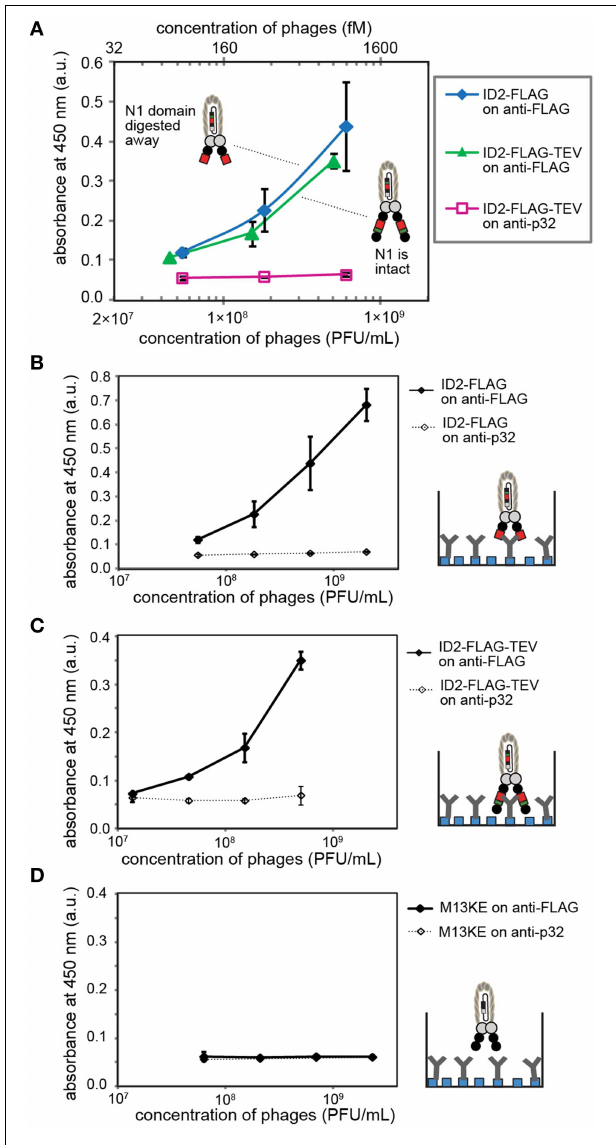
FIGURE 5 | (A) ELISA detects inserted FLAG sequences before and after digestion of ID2-FLAG-TEVrs phage by TEV protease. When tested side-by-side, digested and non-digested phage exhibit similar binding response. This observation suggests that the N2 domain does not interfere with binding of anti-FLAG antibody. (B–D) Control experiments in which we compared (B) binding of digested phage to matched (anti-FLAG) and mismatched (anti-p32) antibody; (C) binding of undigested phage to matched/mismatched antibody; (D) binding of insert-free phage to matched/mismatched antibody. Antibodies were immobilized on protein-A coated wells. Data represents average from three independent wells; error bar is one standard